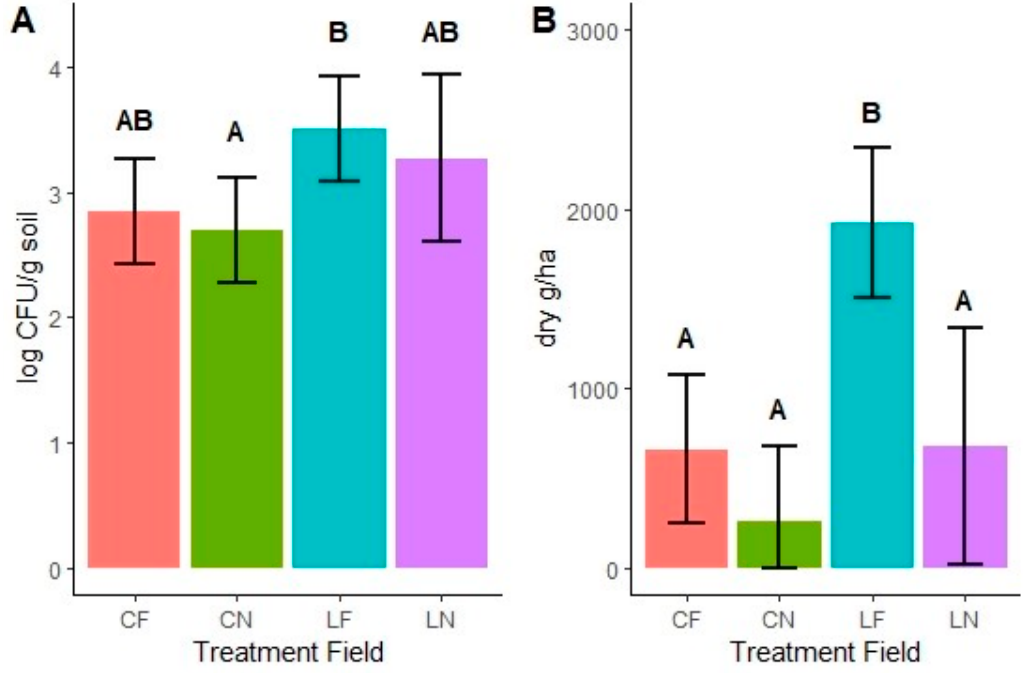
Figure 1. Clostridium perfringens and fecal matter inputs with 95% CI. ( A ) C. perfringens detection results reported in log CFU/dry g soil. Bars denote 95% confidence intervals (CI). LEISA flooded fields were significantly different than CN p < 0.05, shown with letter groupings. ( B ) Estimated fecal matter inputs per treatment field reported in dry g fecal matter/ha. Bars denote 95% CI. LEISA flooded fields had significantly greater fecal inputs than other treatment fields ( p < 0.05) Tallahatchie and Leflore County, Mississippi, November 2017–March 2018.